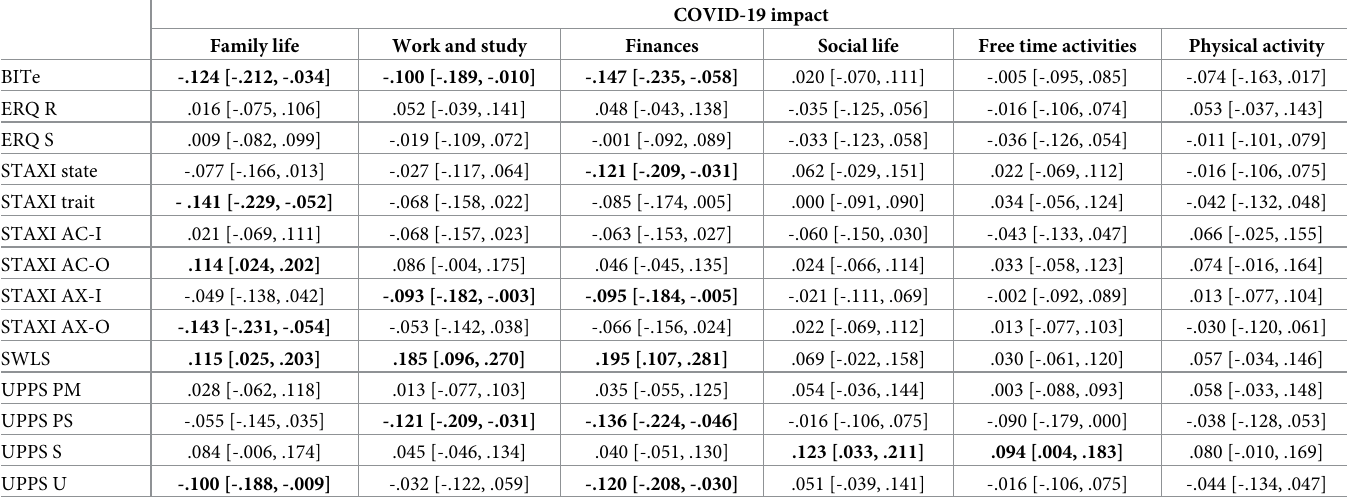
Table 1. Correlations between individual difference measures and self-reported COVID-19 impacts.